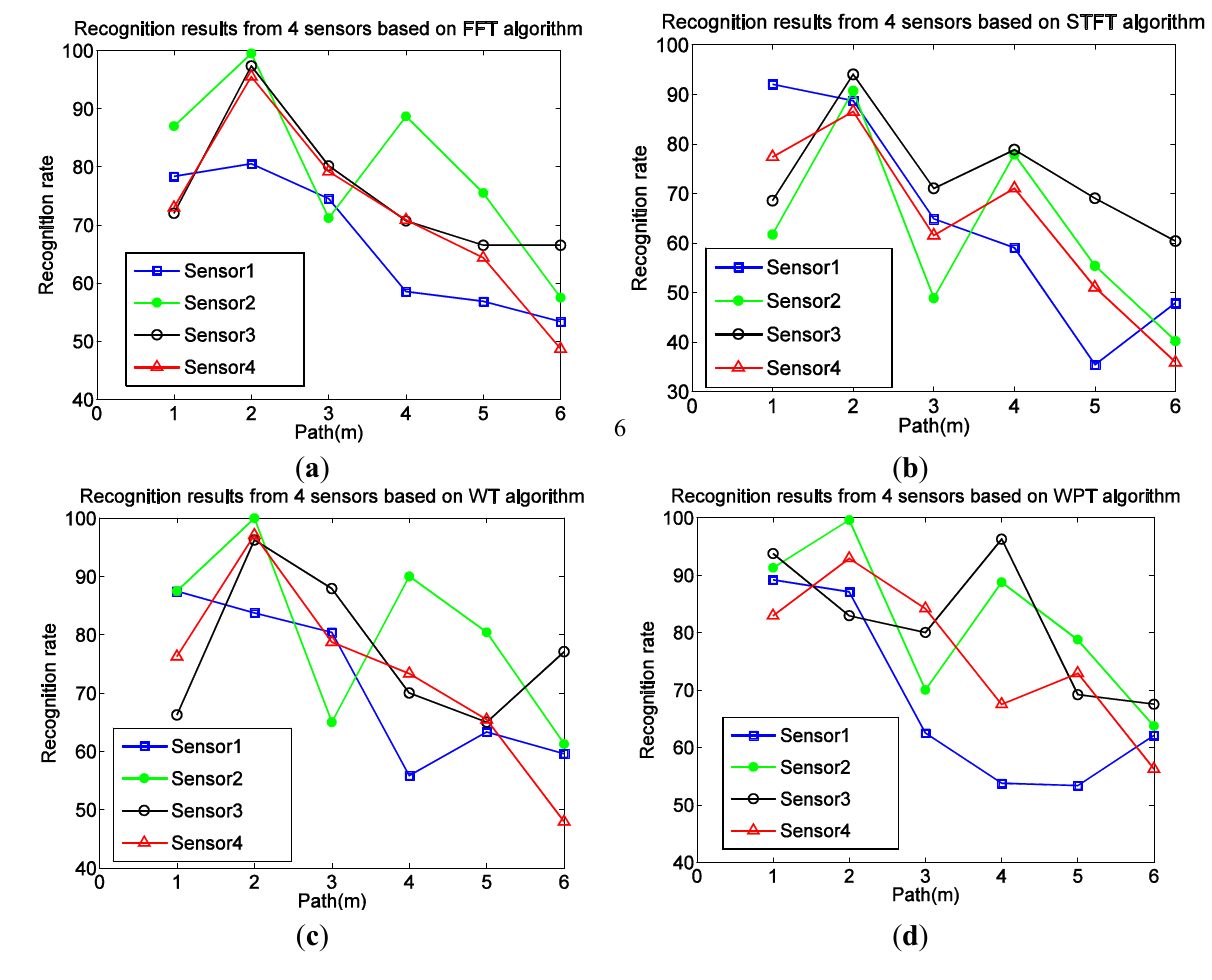
Figure 11. Recognition results under different algorithms. ( a ) Recognition results under FFT algorithm. ( b ) Recognition results under STFT algorithm. ( c ) Recognition results under WT algorithm. ( d ) Recognition results under WPT